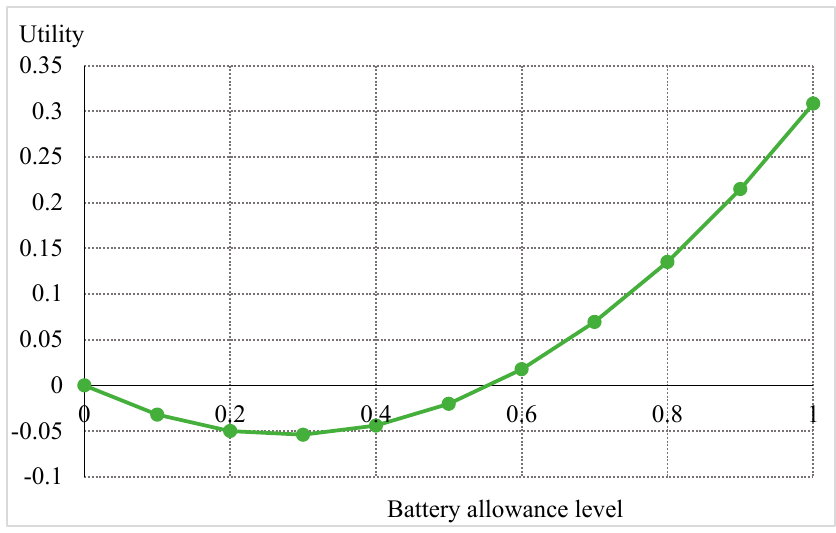
Figure 3. The utility of drivers by the battery allowance for V2G.